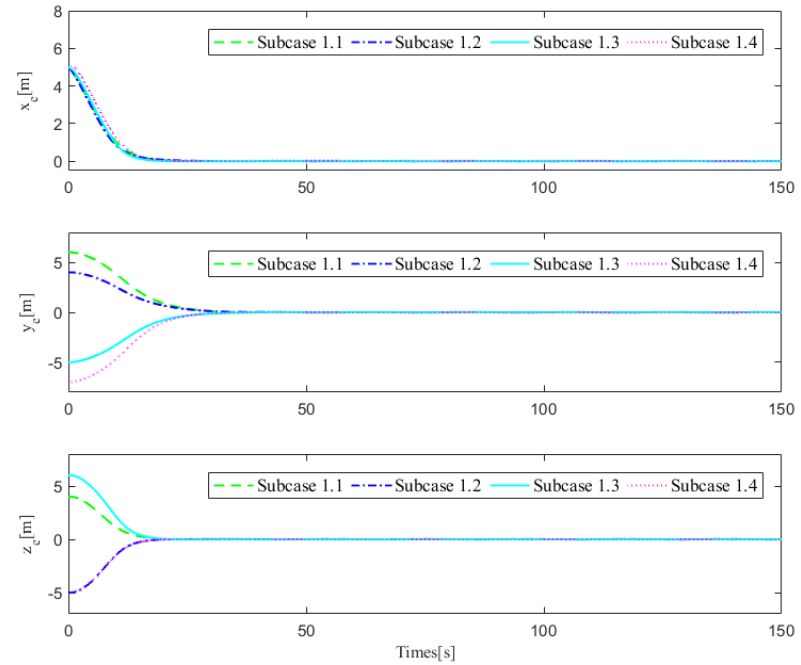
Figure 4. Tracking errors of Case 1.